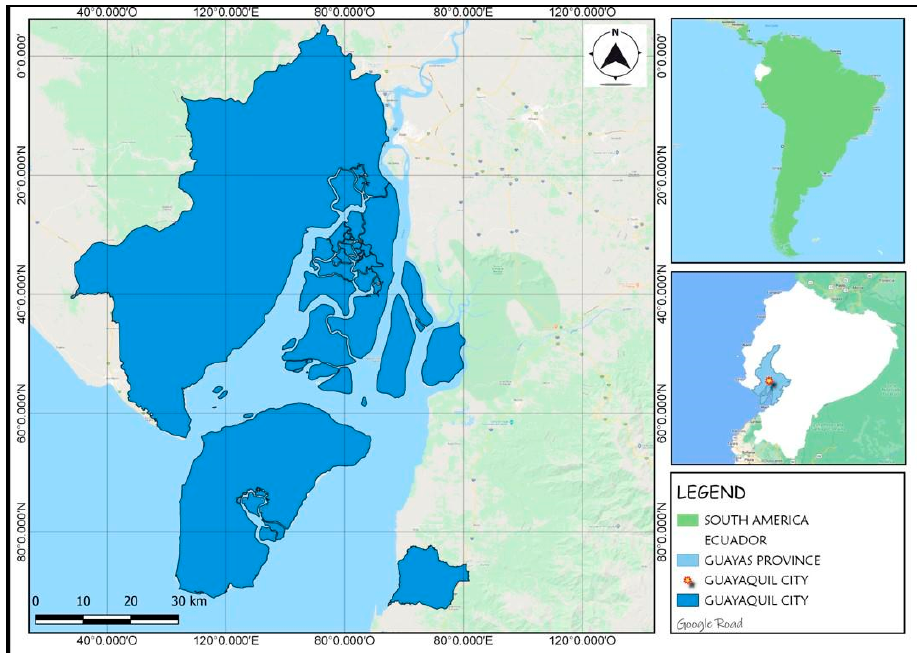
Figure 1. Guayaquil city, Ecuador.